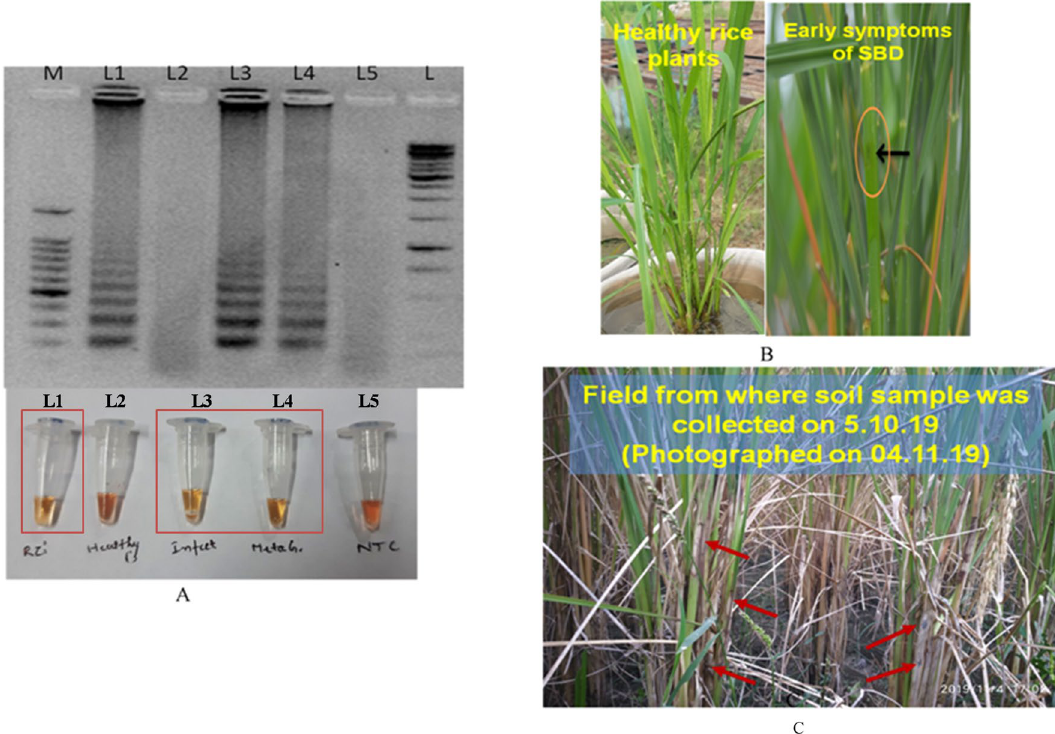
Figure 7. LAMP assay results with environmental samples and soil from rice field. Upper panel in the figure shows agarose gel electrophoresis results whereas lower panel shows reaction tubes. ( A ) M: Marker; L1: R. solani AG-1 IA isolate PU RS2; L2: healthy plant; L3: Infected plant; L4: Soil DNA from rice field; L5: NTC. ( B ) Photographs of healthy and early symptoms of sheath blight disease on rice just after 24 h of infection infected rice plants used in the study. Orange color circle indicate lesions ( C ) Disease incidence after one month of collection of soil samples for performing the LAMP assay. Red arrows indicate